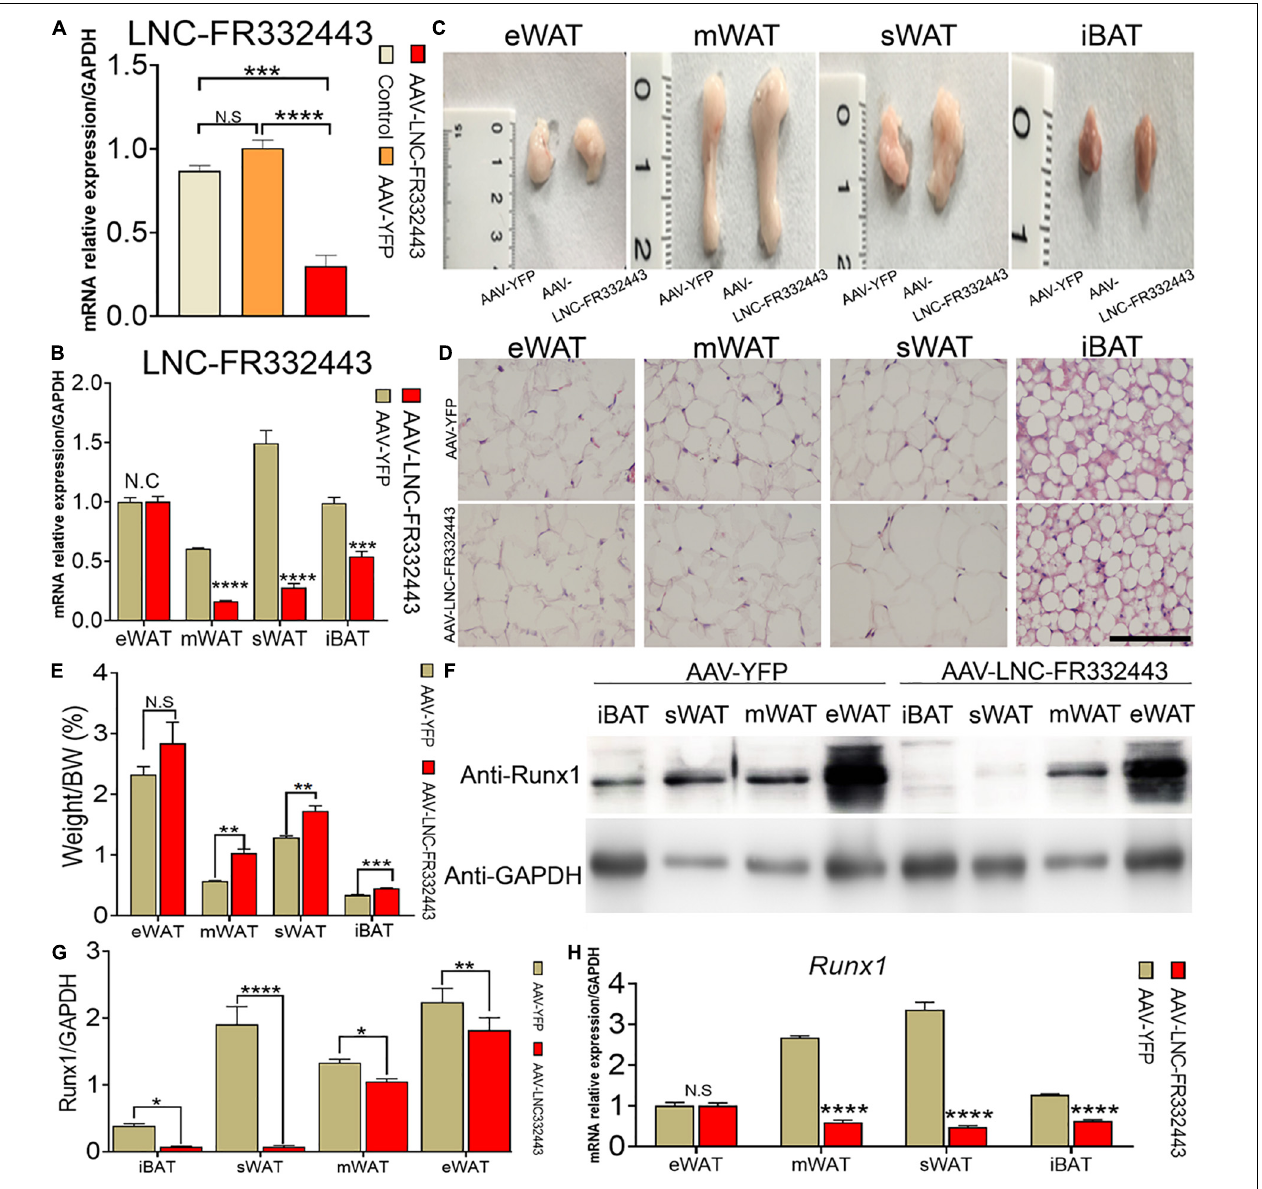
FIGURE 3 | Morphological and functional changes in mouse adipose tissue with specific knockdown of Lnc-FR332443 . (A) The efficiency of Lnc-FR332443 knockdown by intraperitoneal injection of AAV virus. (B) The expression of Lnc-FR332443 in adipose tissue (eWAT, mWAT, sWAT and iBAT) after wild-type mice were intraperitoneally injected with AAV virus. (C) Representative graphs of eWAT, mWAT, sWAT and iBAT from the AAV-Lnc-FR332443 and control mice. (D) HE staining for eWAT, mWAT, sWAT and iBAT in the AAV-Lnc-FR332443 mice and control mice. Scale bar, 100 µ m. (E) The proportion of adipose tissue (eWAT, mWAT, sWAT and iBAT) to total body weight (weight%). (F) Western blot analysis of Runx1 expression in different adipose tissues with Lnc-FR332443 knockdown. (G) Quantification data of panel (F) . (H) qRT-PCR of Runx1 expression in different adipose tissues with Lnc-FR332443 knockdown. All data are expressed as the mean ± SEM, N.S denotes not significant, N = 3, * P < 0.05, ** P < 0.01, *** P < 0.001, and **** P <